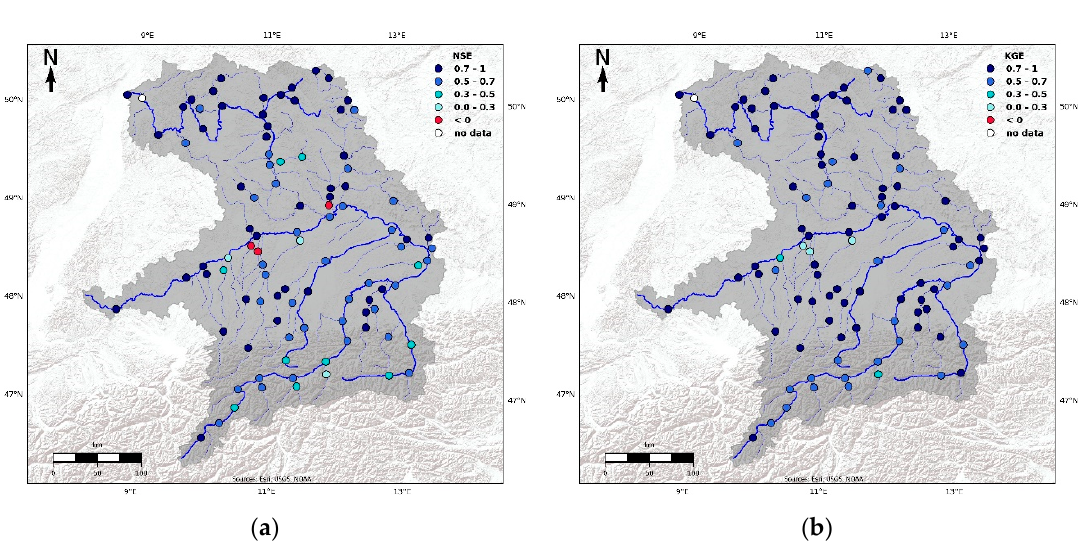
Figure 6. Maps of the WaSiM model performance for the 98 gauges (( a ) NSE, ( b ) KGE) for the reference period (1981–2010). Blueish colors indicate values above zero with better performance indicated by darker colors. Red dots represent gauges with values below zero and white dots gauges with no observations available for the reference period.